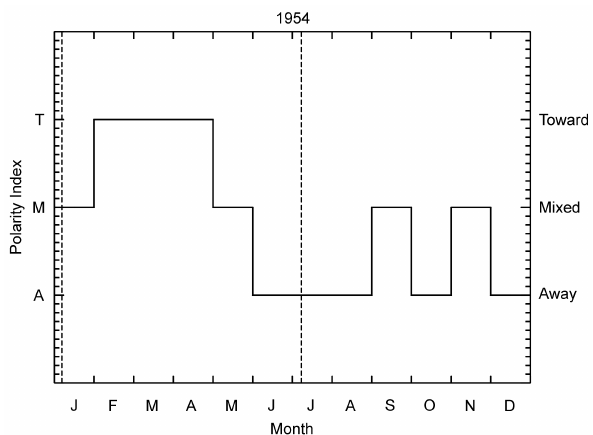
Fig. 8. Monthly solar wind magnetic polarity indices (Svalgaard, 1972) for 1954. A polarity was judged to be dominant during a month if it occurred for > 50% of the days. The dashed vertical lines indicate minima for the Russell-McPherron effect. Toward and away is with reference to the Sun.